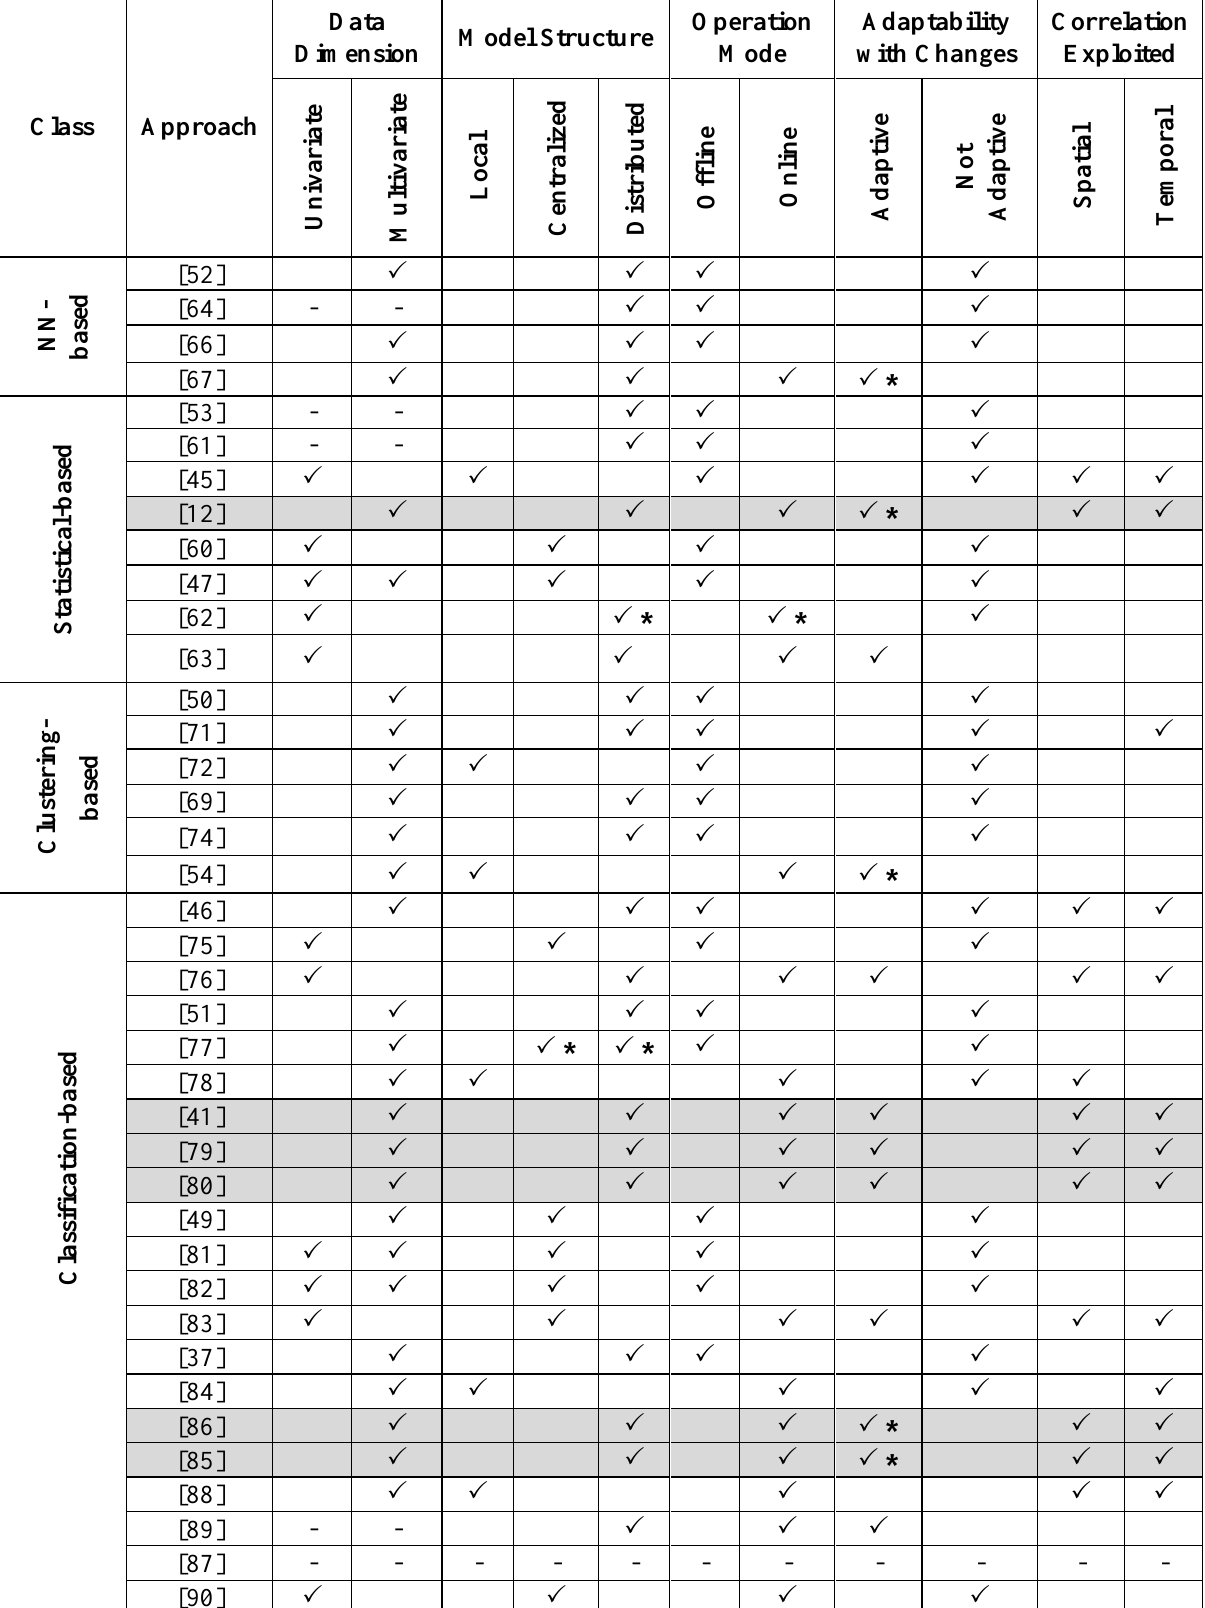
Table 1. Evaluation of current anomaly detection models in